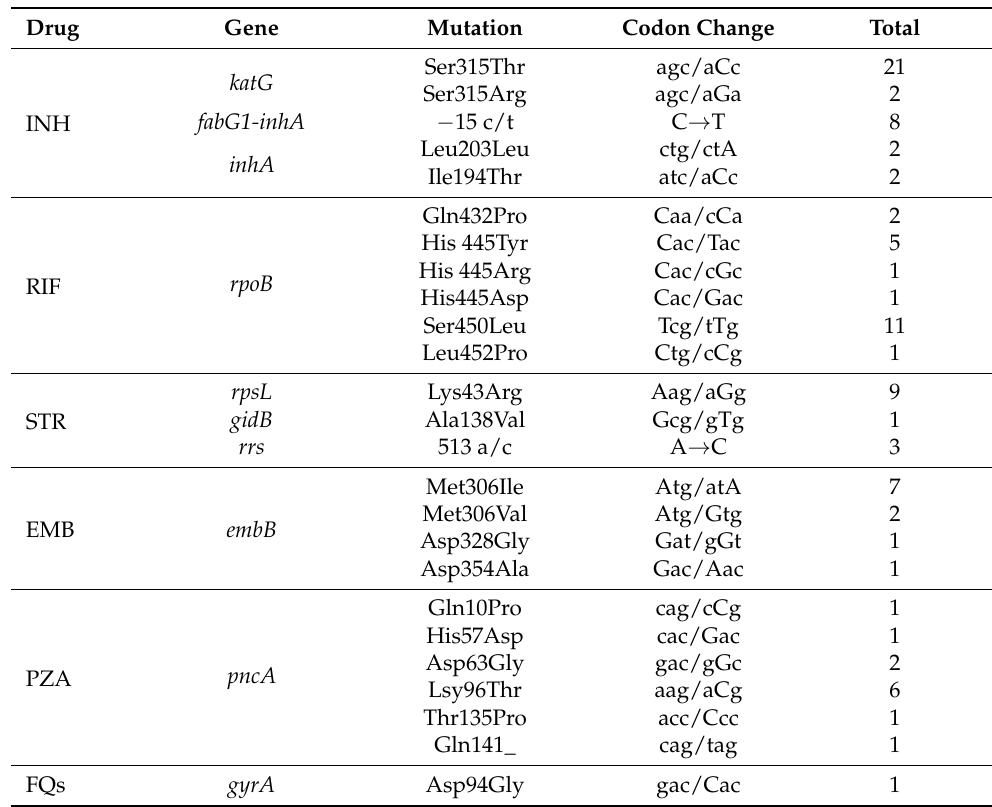
Table 2. Detected mutations that mediate resistance to first-line anti-TB drugs in 37 resistant MTBC strains in urban and slum areas of Nairobi, Kenya (2010–2015). Drug Gene Mutation Codon Change Total Ser315Thr katG INH